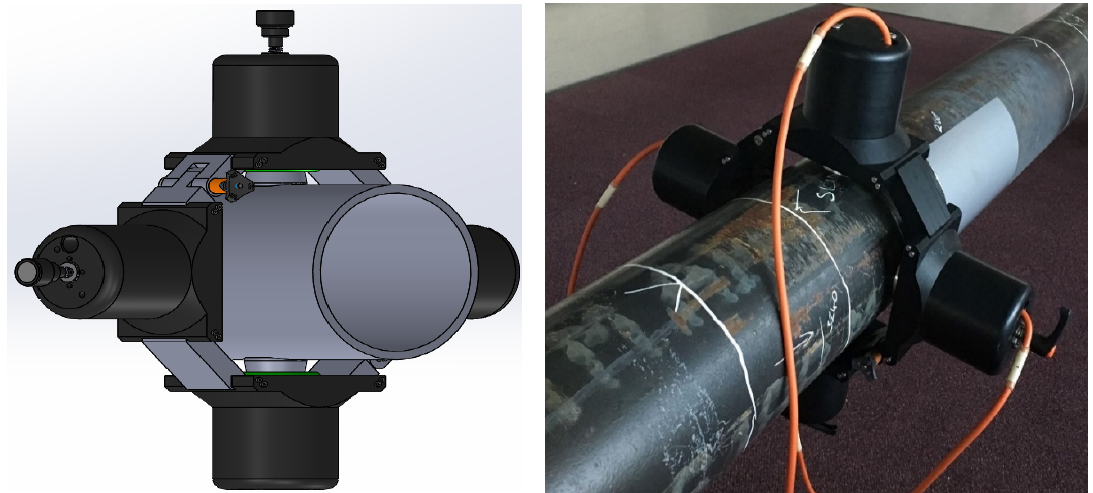
Figure 11. HPUT Collar CAD ( left ) and placed onto 6-inch pipe ( right ).